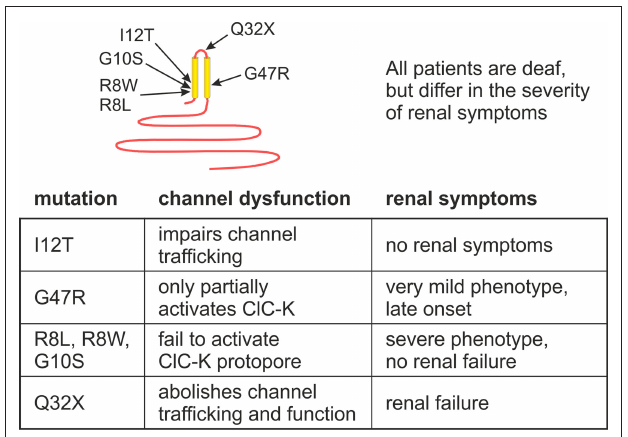
Figure 5 | Disease-causing barttin mutations result in deafness and varying severity of renal symptoms depending on the type of functional deficits of ClC-K/barttin